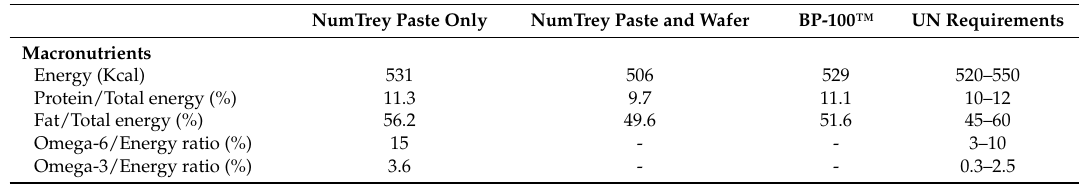
Table 1. Nutritional composition of the RUTFs used in the intervention per 100 g of RUTF. NumTrey Paste Only NumTrey Paste and Wafer